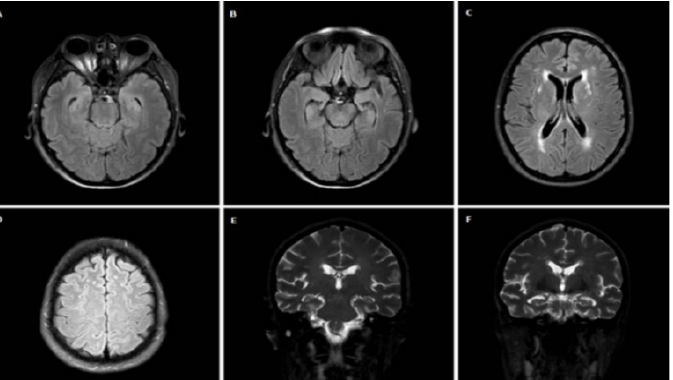
Figure 4. Brain MRI of case 4. Axial FLAIR images ( A – D ) and coronal T2 images ( E , F ) reveal hyperintense lesions attributed to chronic small vessel ischemia (Fazekas II) and some degree of cortical atrophy in temporal lobes.